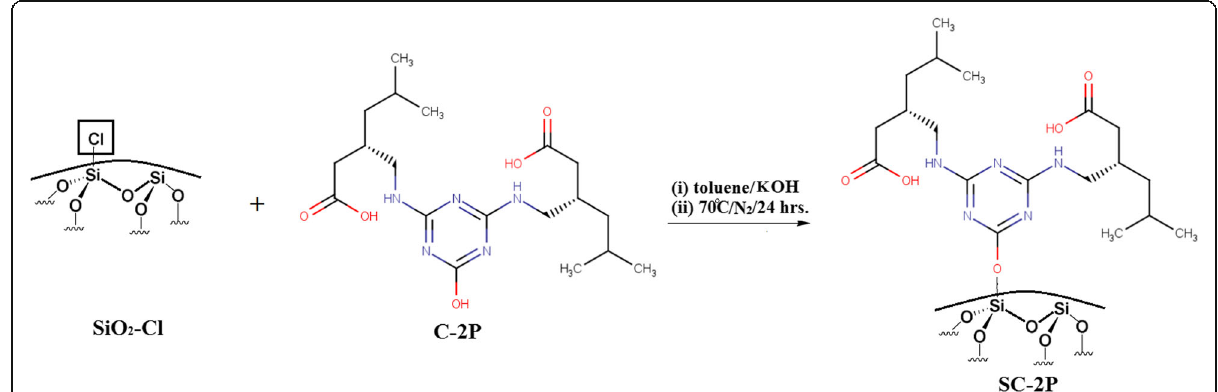
Fig. 2 Synthesis of the bonded silica SC-2P